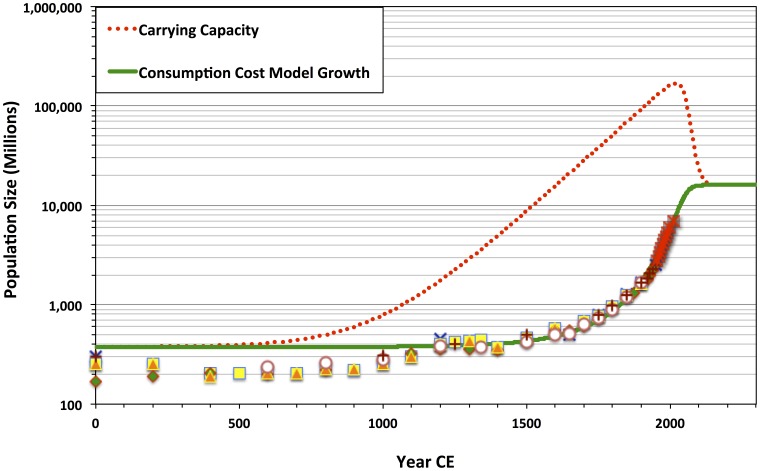
Consumption-cost (CC) model trajectory tuned by inspection to fit P2012 CE = 6.999 billion.In this case, ; ; ; b = 2.54; ; and . This case results in  and , demonstrating that—according to the CC model—initial conditions established between 1 and 1500 CE can largely account for the historical pattern of modern super-exponential growth and the projected trend of population deceleration through 2100 CE.